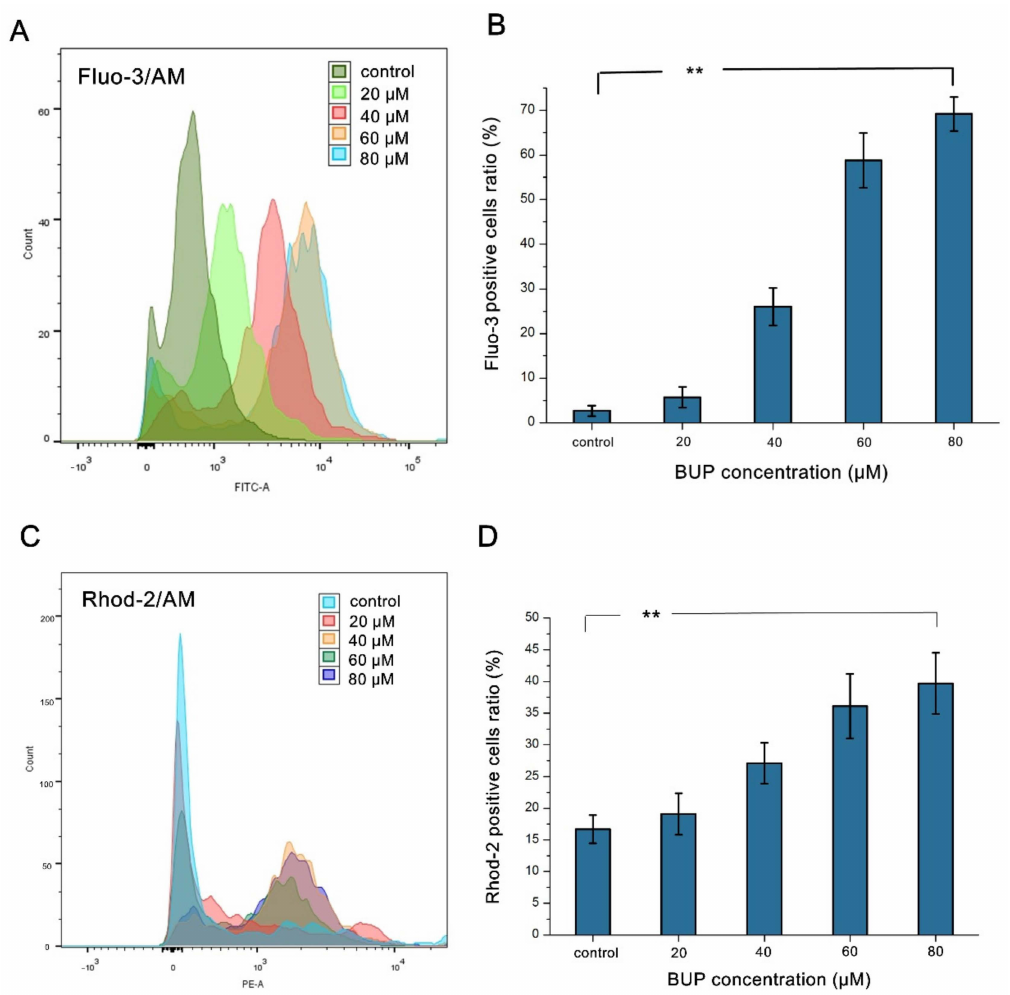
Figure 6. Analysis of cytosolic and mitochondrial Ca2+ levels in BUP-treated A549 cells, showing: ( A , C ) analysis of fluo-3 ( A ) and rhod-2 ( C ) dyeing by flow cytometry, ( B ) measurement of fluo-3 fluo- rescence intensity, ( D ) measurement of rhod-2 fluorescence intensity. ** p ≤ 0.01 vs. negative